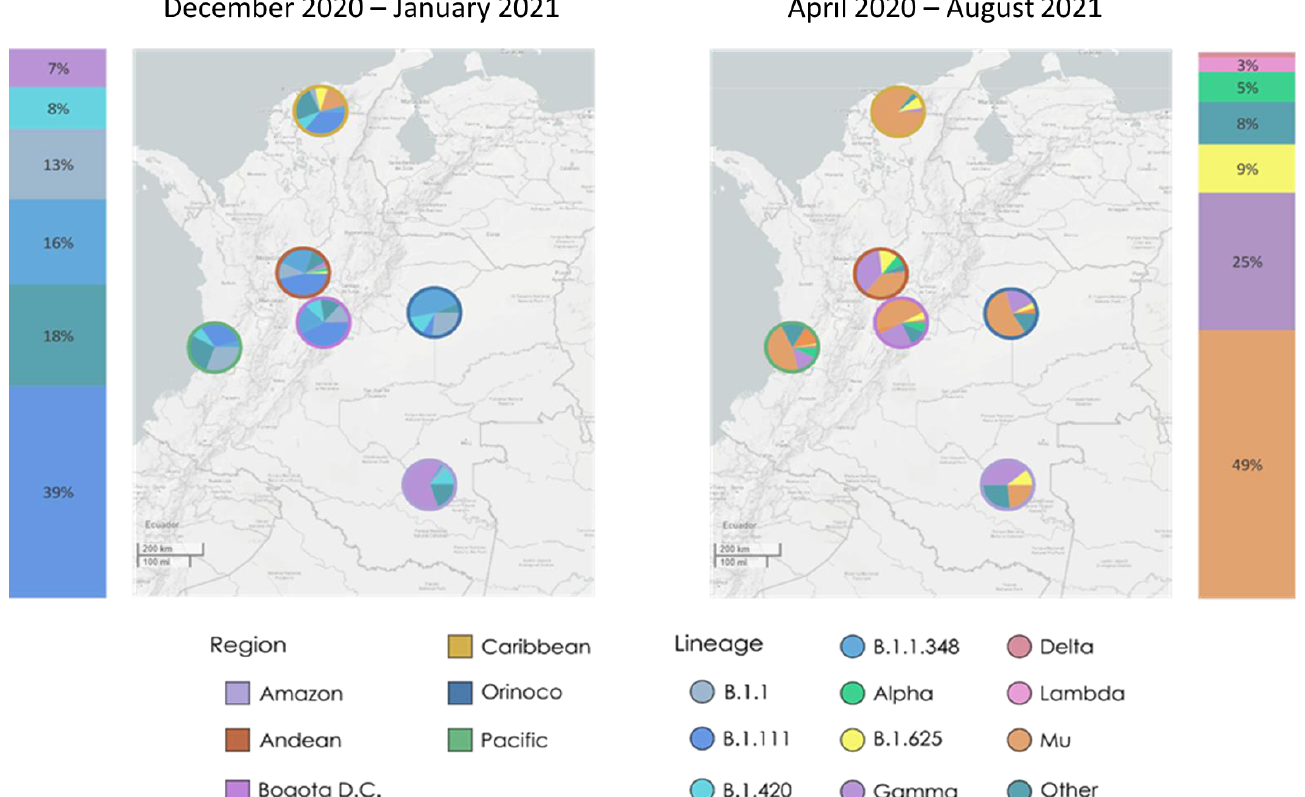
Figure 1. Spatiotemporal distribution of the most representative SARS-CoV-2 lineages in Colombia (bars) and its regions (map). SARS-CoV-2 lineage distribution in the five Colombian regions and Bogotá D.C. December 2020–January 2021 ( left ), and April–August 2021 ( right ). Ring colors repre- sent the region. The interactive map is available at https://microreact.org/project/6GjGXeoUW7 uVauMTFCFEkE/d9357c6c (accessed on 8 January 2022) [20]. Figure design was based on